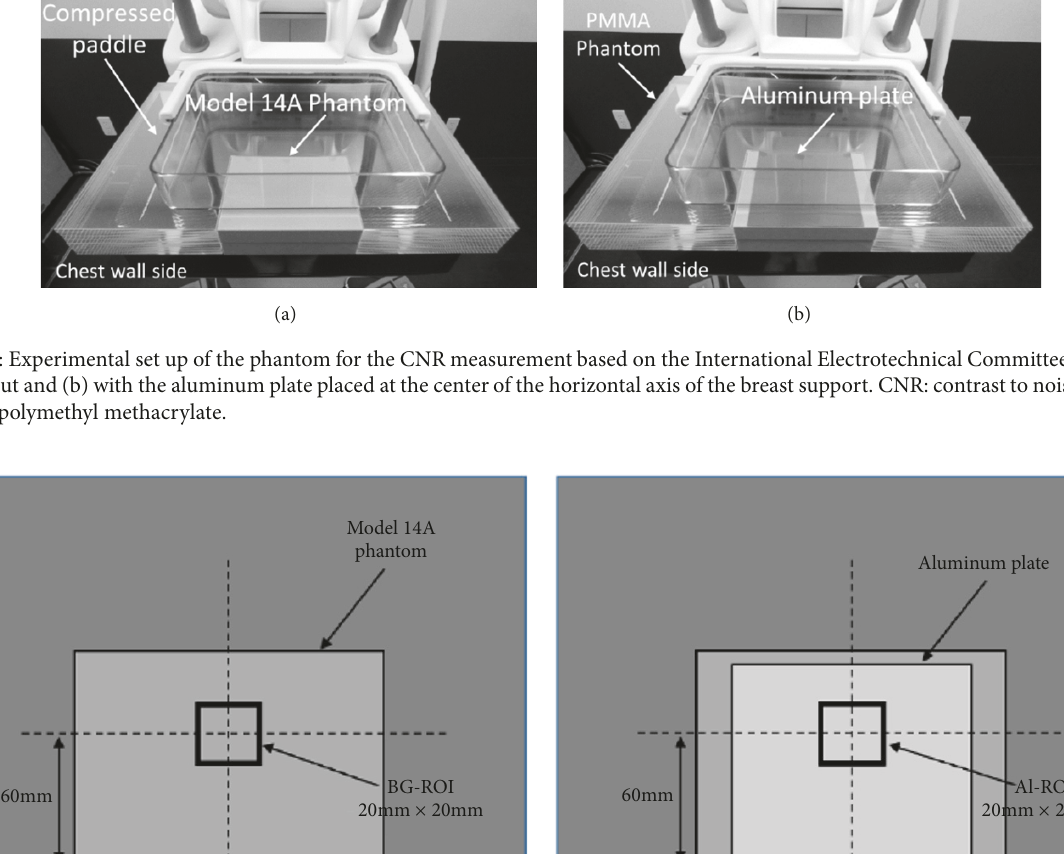
CNR. Factors with t-values below |2.00| were defined as